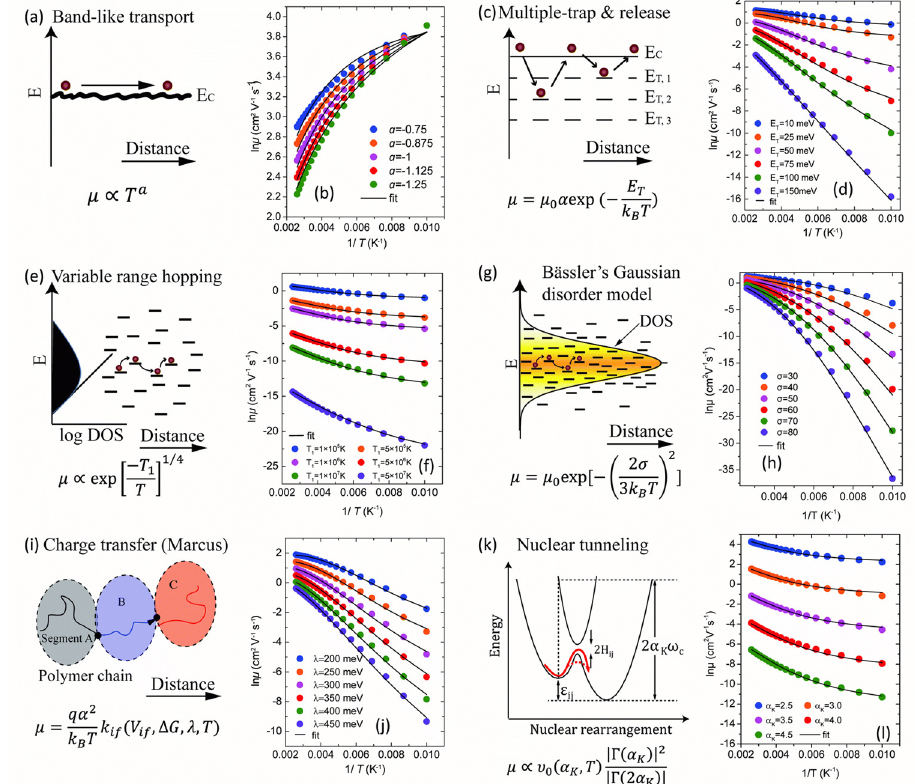
Figure 2. Various charge transport mechanisms for organic semiconductors ( a ) Band-like transport and ( b ) its corresponding mobility-temperature relationship; ( c ) Multiple-trap and release and ( d ) its corresponding mobility-temperature relationship; ( e ) Variable range hopping and ( f ) its corresponding mobility-temperature relationship; ( g ) Bässler’s Gaussian disorder model and ( h ) its corresponding mobility-temperature relationship; ( i ) Charge transfer (Marcus) and ( j ) its corresponding mobility-temperature relationship; ( k ) Nuclear tunneling and ( l ) its corresponding mobility-temperature relationship. Reproduced with permission from [36] Royal Society of Chemistry, 2017.